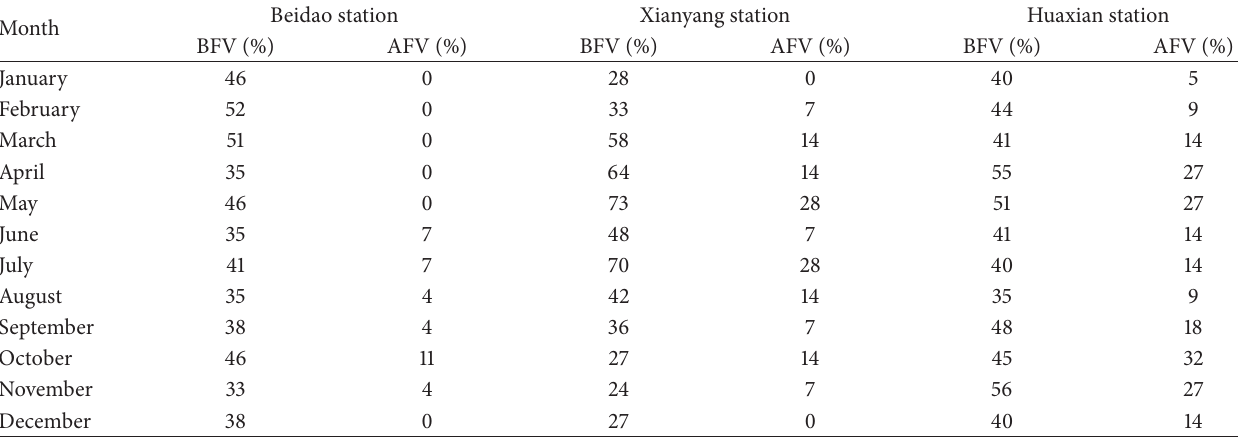
Table 2: The frequency of monthly flow satisfying the maximum instream ecological flow in the Wei River.